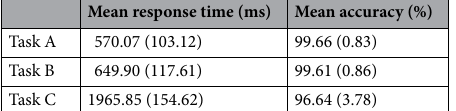
Table 1. Accuracy and response times. Values in parentheses are standard